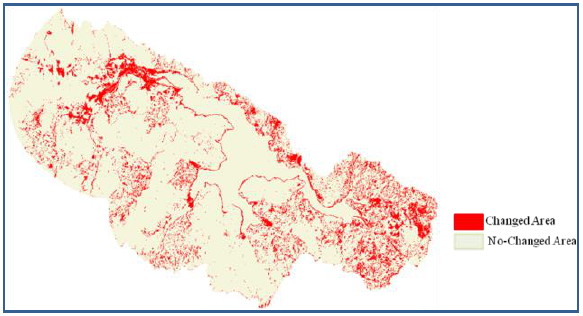
Figure 4. Changed and no-changed area Direction images were produced based on given equations in Figure 2. Direction images for greenness/brightness, wetness/brightness and wetness/greenness were given in Figure 5.